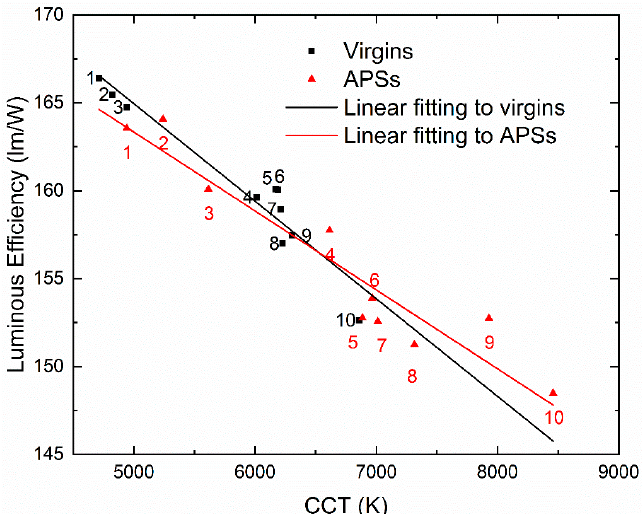
Figure 4. Relationship between luminous efficiencies and CCTs for white LEDs with and without APSs. The data are chosen with APS-1, APS-2, APS-3, APS-4, and APS-5 at the nominal CCTs of 5000 and 6000 K. The same numbers of black and red data points correspond to the same white LEDs with and without APSs. The fitting lines show same color as the experimental data.